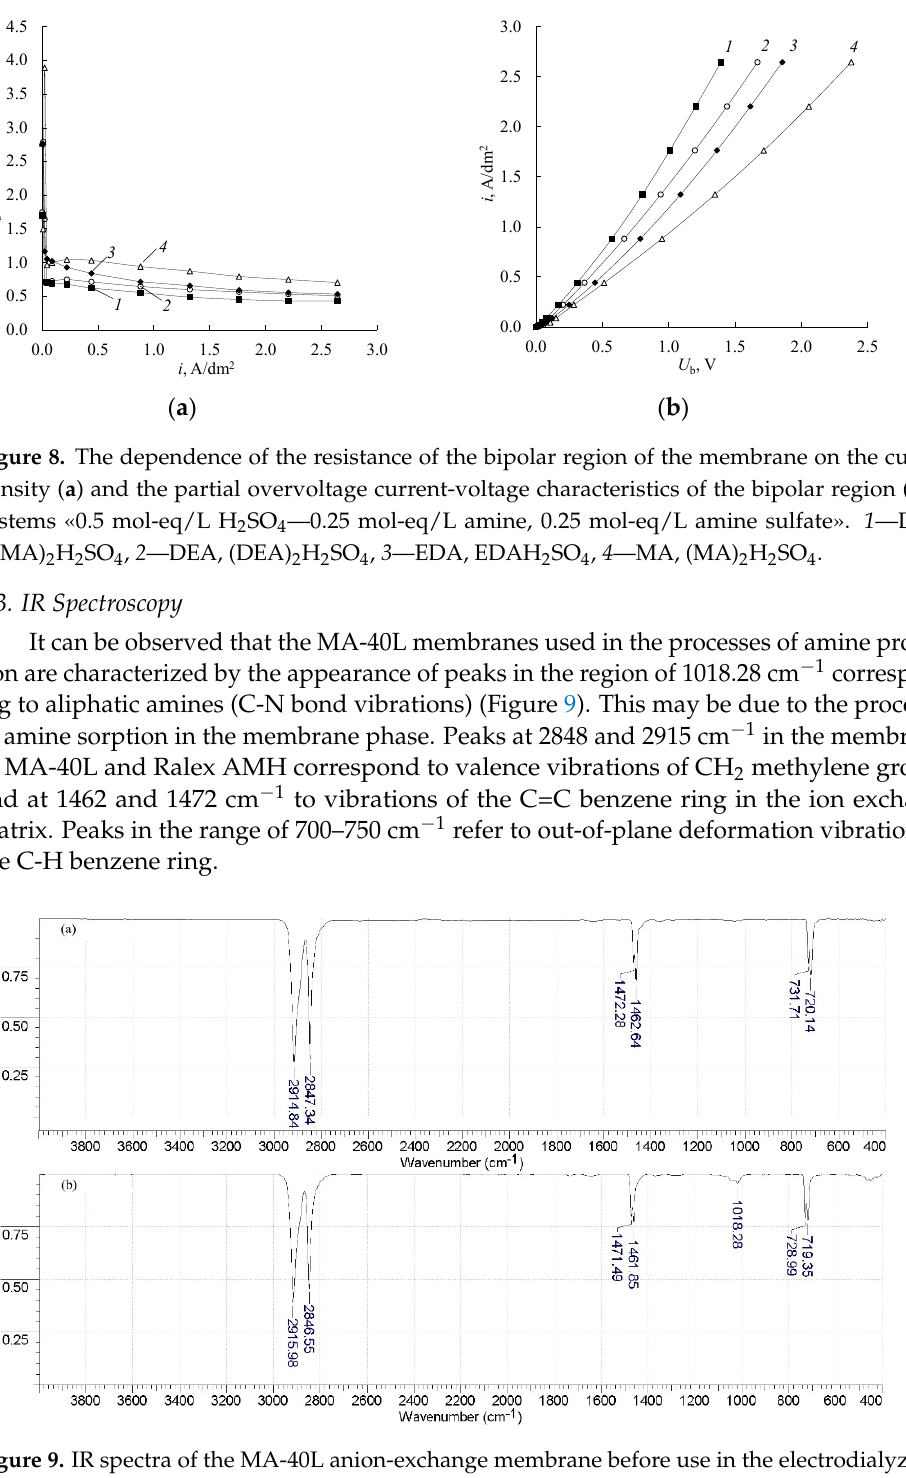
Figure 10. IR spectra of the Ralex AMH anion-exchange membrane before use in the electrodialyzer ( a ) and after use in the electrodialyzer ( b ). 3.4. Voltammetry To estimate the effect of the circulation rate of amine and sulfuric acid solutions through the chambers of a laboratory electrodialyzer in the electrodialysis process, the current-voltage characteristics of the bipolar membrane aMB-2m and the anion-exchange membranes Ralex AMH and MA-40L were calculated. It is shown that there are no electrodiffusion limiting currents on the membranes in the region of the studied current densities (Figures 11 and 12). This indicates that additional processes typical of currents exceeding the limiting electrodiffusion current, some of which lead to deterioration of the